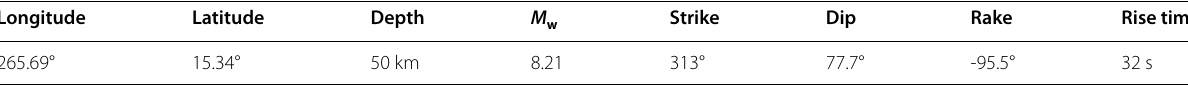
Table 2 Source parameters of the 2017 Tehuantepec earthquake